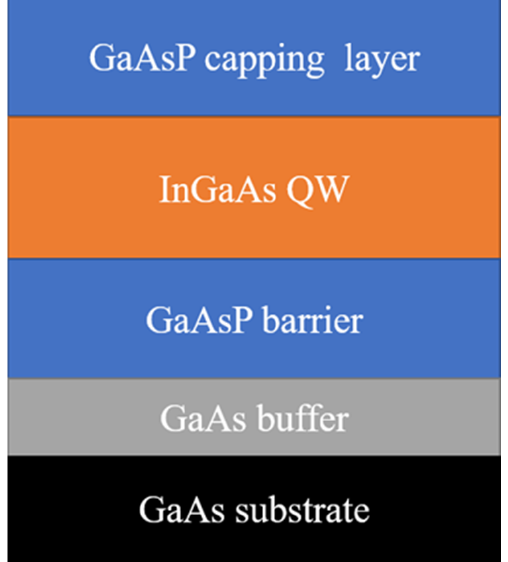
Figure 1. Schematic of the InGaAs/GaAsP quantum well. compositions were fixed at 38% and 20% in the InGaAs QWs and GaAsP barriers,